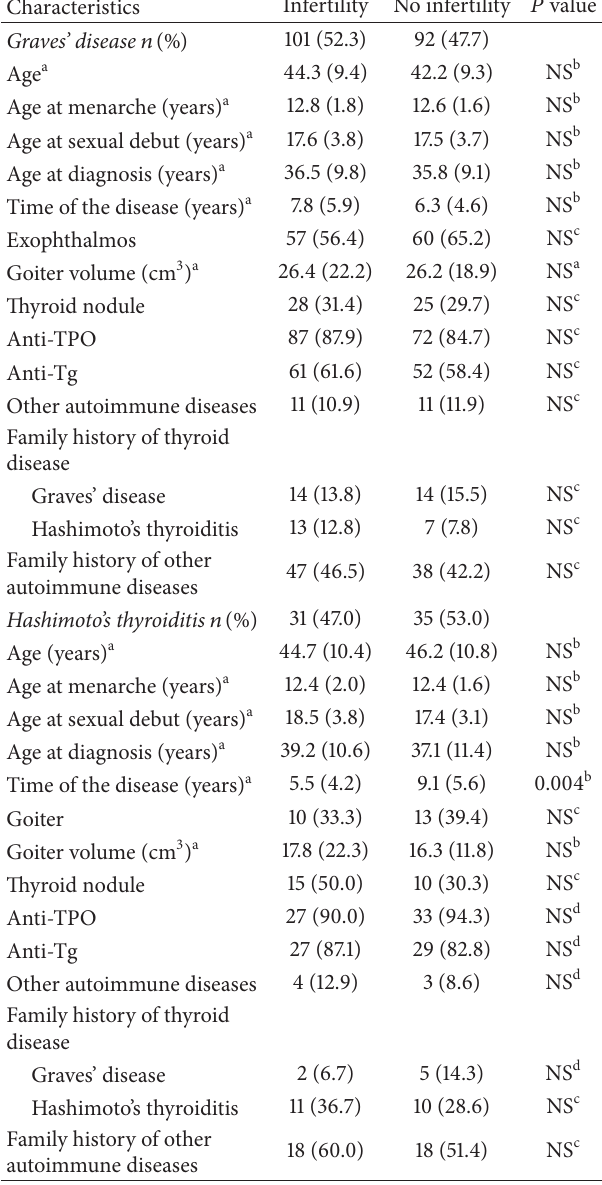
Table 2: Pregnancy characteristics and primary ovarian insuffi- ciency in the women with GD and HT who reported a period of infertility and those who did